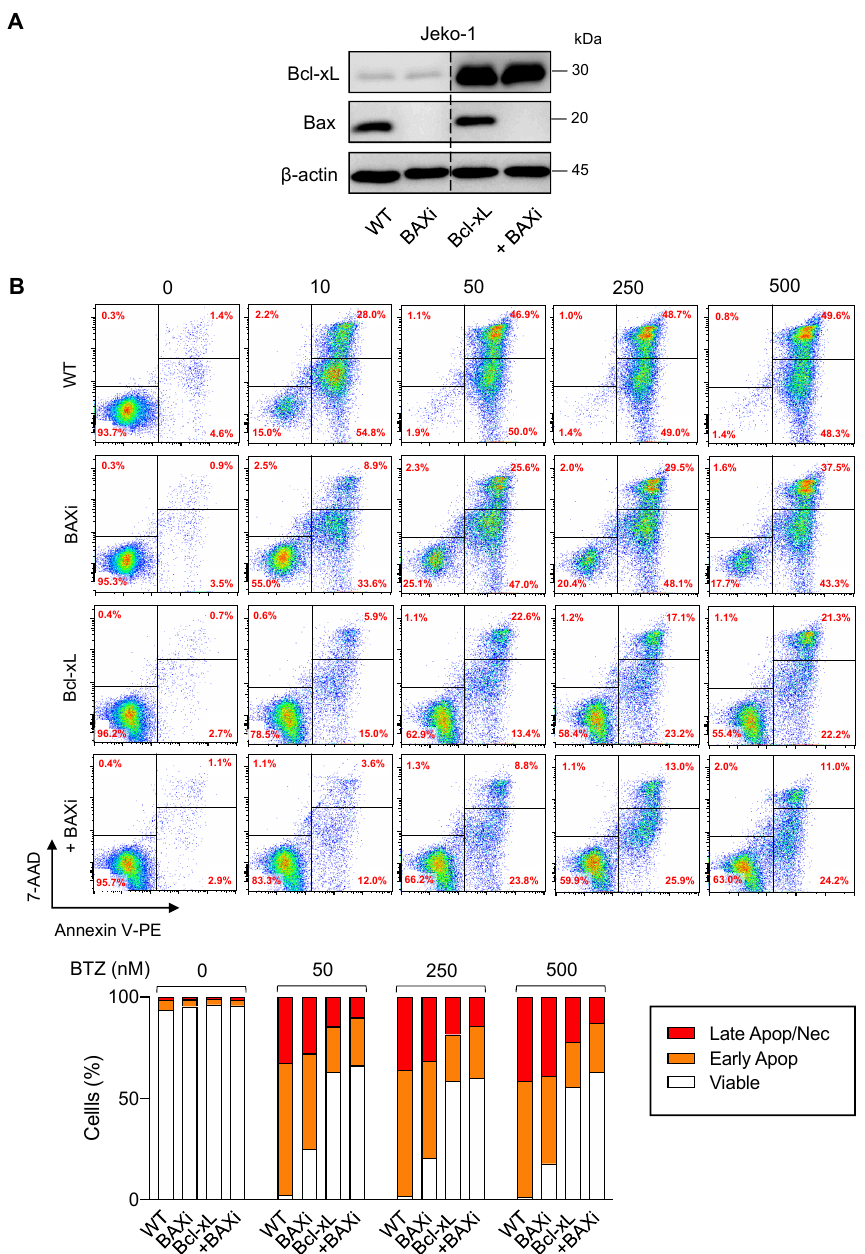
Figure 9. Generality of the observed Bcl-xL and Bax effects in BTZ-induced apoptosis in MCL cells. Genetic manipulation of Bcl-xL and Bax was similarly performed in human MCL-derived Jeko-1 cells using transgene and/or CRISPR/Cas9 system. After which, cells were treated with BTZ (0–500 nM) for 24 h. ( A ) Western blot analysis of Bcl-xL and Bax levels in control Jeko-1 (WT), Bax-depleted (BAXi), Bcl-xL-overexpressed alone (Bcl-xL) or in combination with Bax depletion (Bcl-xL + BAXi) cells prior to experiments. The dashed line separates juxtaposed lanes taken from the same experiment and blot image. ( B ) Analysis of cell death by Annexin V/7-AAD assay. Percentages of Annexin V single-positive cells defining early apoptosis, and Annexin V and 7-AAD double- positive cells defining late apoptosis/necrosis combining with 7-AAD single-positive cells defining necrosis were